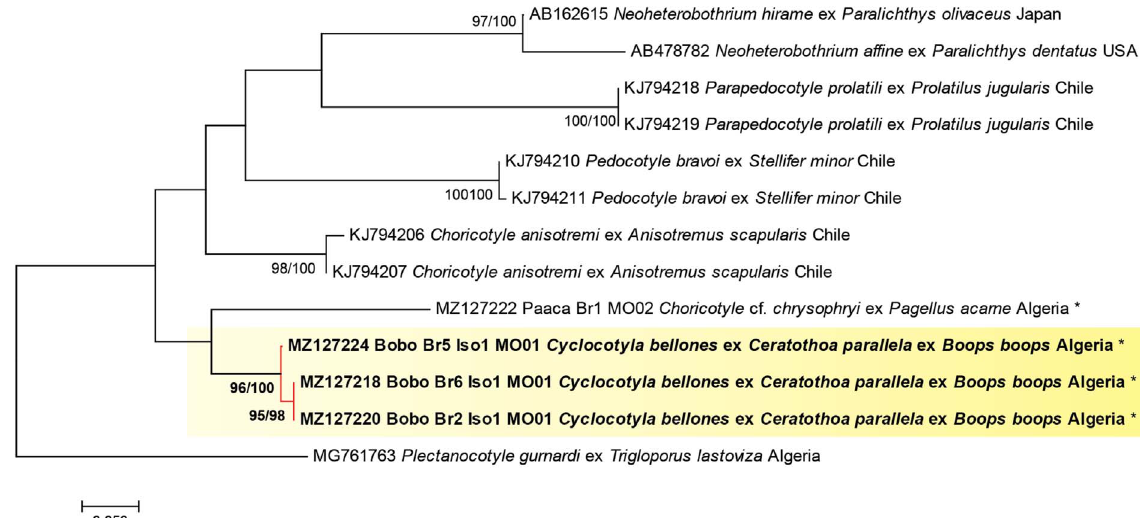
Figure 4. Molecular phylogenetic analysis based on maximum likelihood, inferred from COI sequences of Cyclocotyla bellones in relation to other taxa of diclidophorids; a plectanocotylid was chosen as the outgroup. Values along branches indicate percentage bootstrap support for maximum likelihood and neighbour joining methods (ML/NJ). Nodes without bootstrap values had support lower than 50% and were omitted. There were a total of 389 positions in the fi nal dataset. All specimens of Cyclocotyla bellones were grouped into a single monophylum and showed little variation ( (cid:3) 1%). The tree is drawn to scale, with branch lengths measured in the number of substitutions per site. ex: